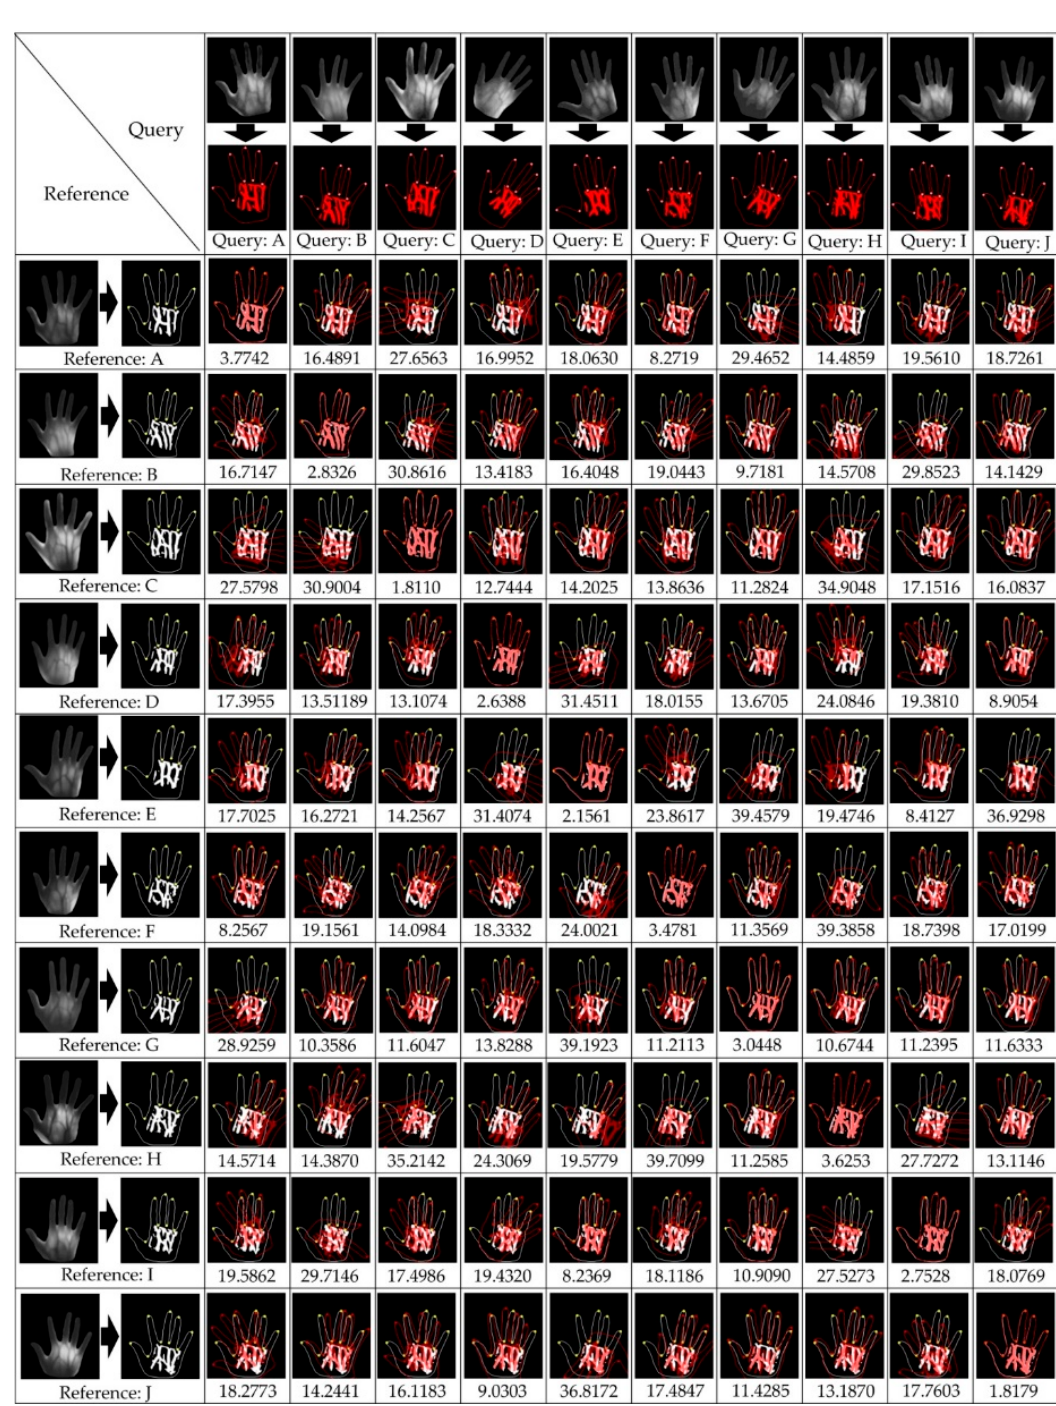
Figure 25. Ten randomly selected vein images in the query set aligned against each of the corresponding ten reference vein images. Images on the diagonal are perfectly matched.